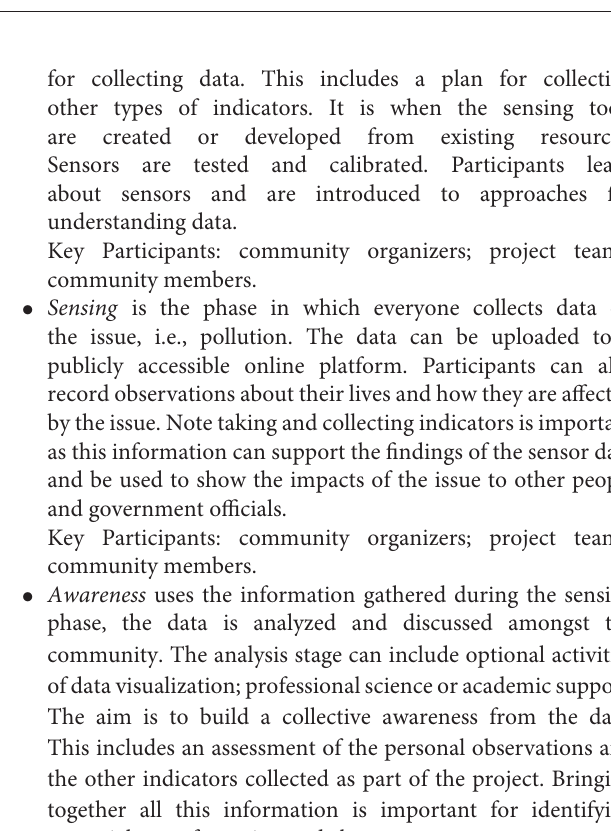
FIGURE 1 | A framework for action-oriented citizen sensing (Woods et al., 2018, pp.